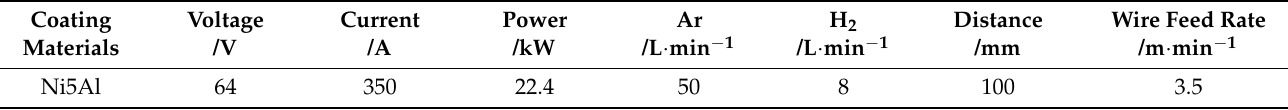
Figure 4. View of plasma spraying with wire feeding: ( a ) Plasma spraying torch, ( b ) Plasma wire spraying process. Table 1. Plasma spraying parameters. Coating Ma- terials